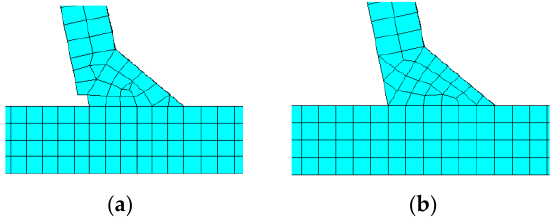
Figure 25. FEM of 80% partial penetration and 100% full penetration. ( a ) 80% ( b ) 100%. Table 9. Comparison of structural stress and fatigue life under di ff erent penetration rates. Penetration